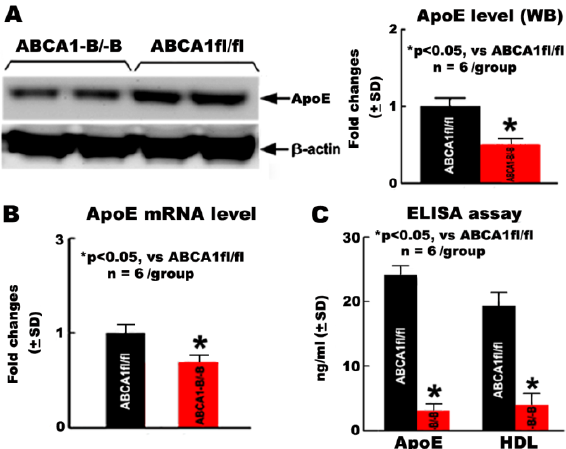
Figure 5. The ApoE and HDL level decreased in the primary cultured oligodendrocyte progenitor cells (OPCs) derived from ABCA1 -B / -B mice compared with OPCs derived from ABCA1 fl / fl mice. ( A ) ApoE protein level measurement by Western blot (WB) assay. ( B ) ApoE mRNA level measured by RT-PCR. ( C ) ApoE and HDL level measurement by ELISA. * p < 0.05, n = 6/group. 2.6. OPCs Derived from ABCA1 -B/-B Mice Exhibit Decreased Migration Compared with OPCs Derived from 5 ABCA1 fl/fl Mice; HDL3 and ApoE2 Treatment Significantly Increase OPC Migration of OPCs Derived from 6 ABCA1 -B/-B Mice 7